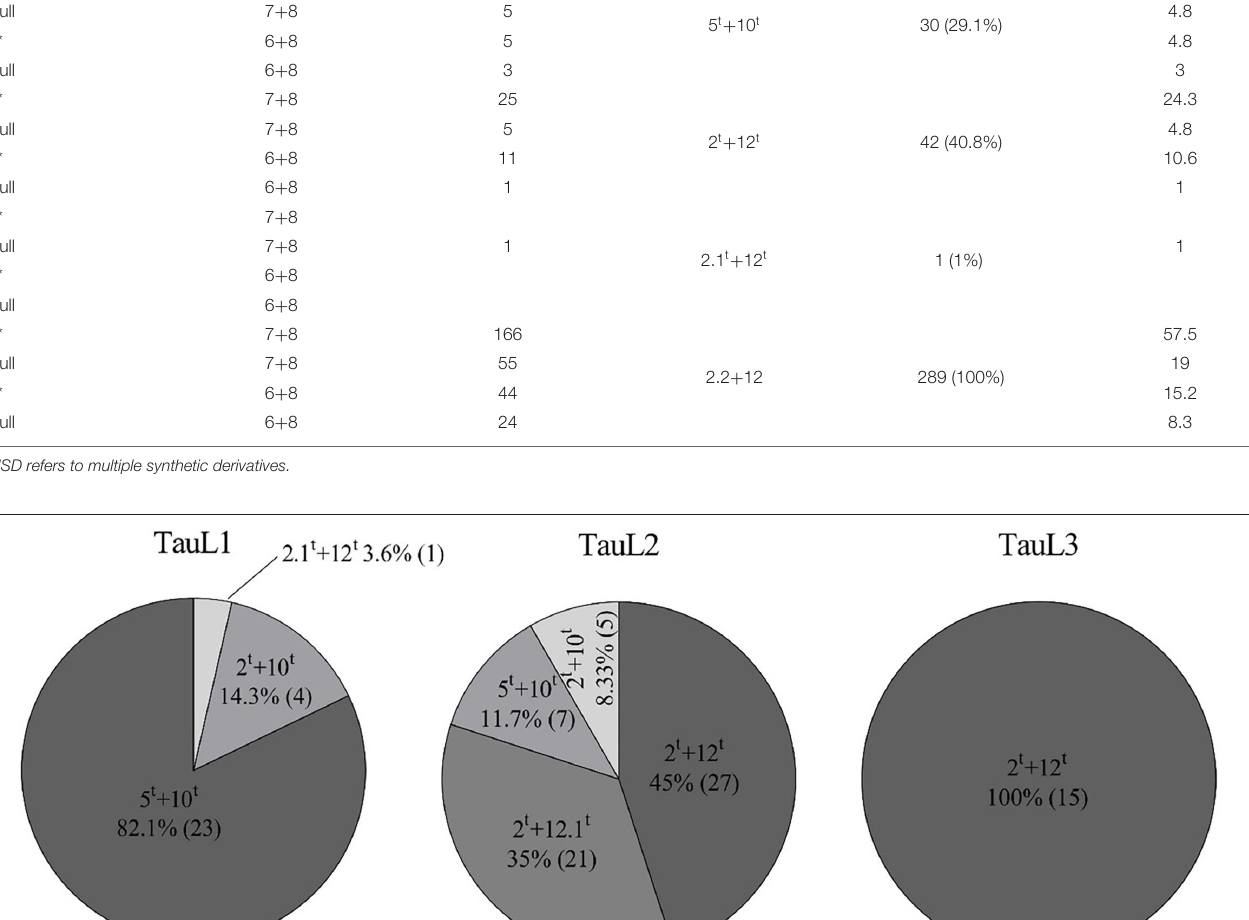
FIGURE 2 | Frequency of the different subunit pairs derived from three lineages of Ae. tauschii : TauL1, TauL2, and TauL3. Numbers in parentheses refer to the number of MSD lines in which the subunit pair appeared.